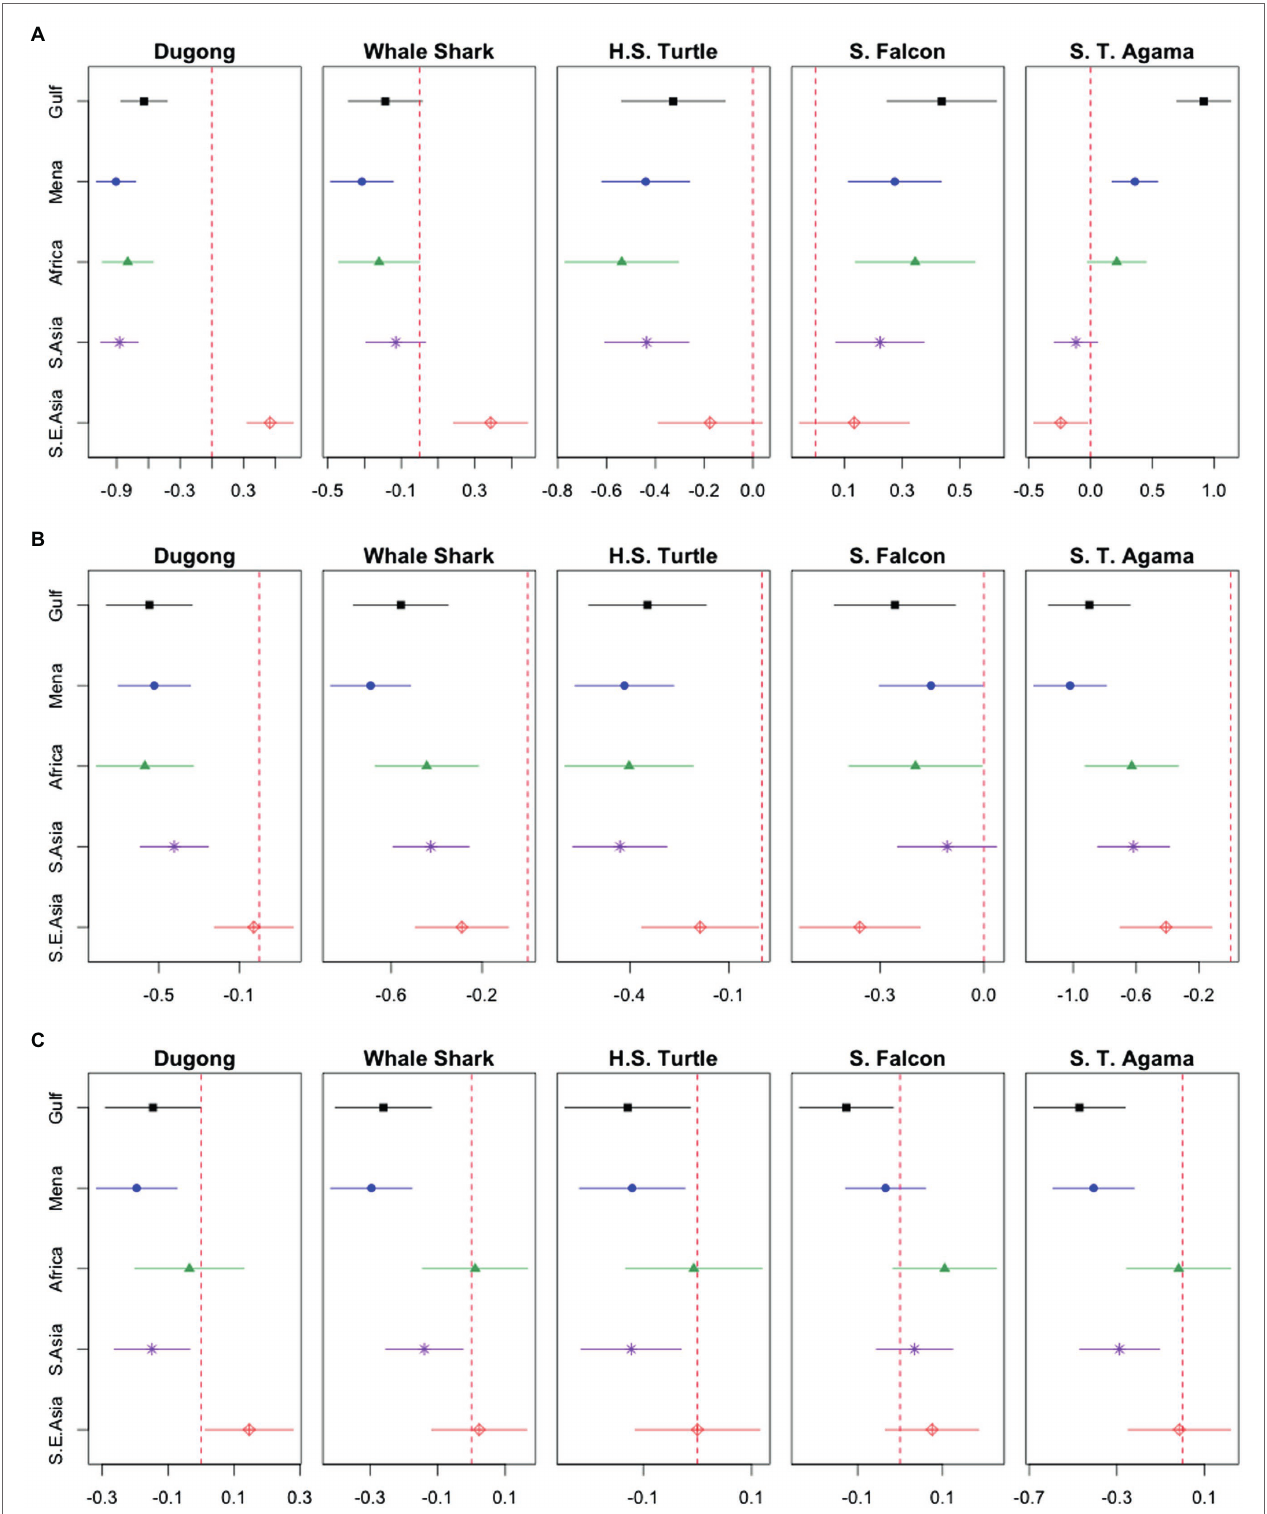
FIGURE 2 | Ordinary least squares coefficients and 95% confidence intervals (CI): Comparing different nationalities. The red dotted line in each plot indicates the baseline WEIRD group. If a certain group’s 95% CI does not cross the red dotted line, it means that the group is significantly different from the WEIRD group at the 0.05 significance level. The “Mixed” group is omitted from the plot for the sake of simplicity though it is included in the analyses. Panel (A) : familiarity. Panel (B) : liking. Panel (C) : endorsement of government